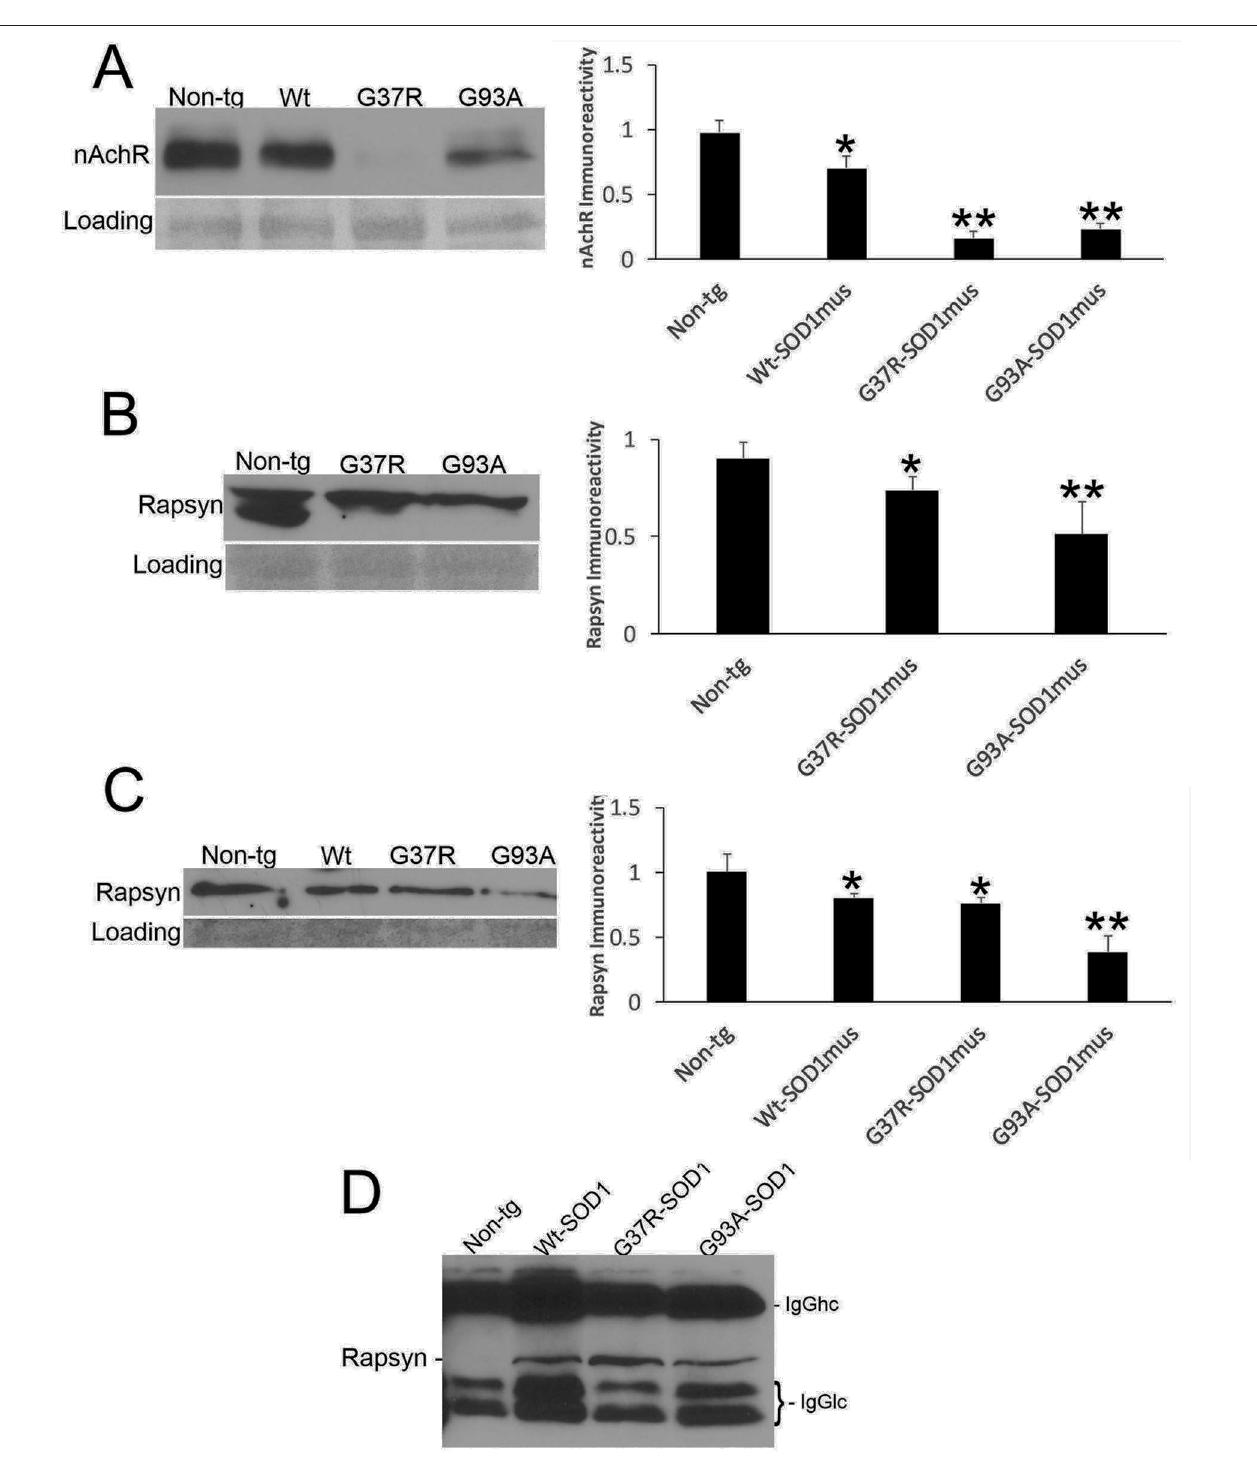
FIGURE 6 | Molecular pathology is prominent at the postsynaptic compartment of the NMJ of hSOD1 mus mice. (A) Western blotting showed depletion of nicotinic acetylcholine receptor (nAchR) in hindleg skeletal muscle of WT, G37R, and G93A mutant mice (mean ± SD, p < 0.05; ** p < 0.01). Ponceau S stained membrane shows protein loading. (B) Scaffold protein rapsyn in diaphragm of G37R and G93A mutant mice (mean ± SD, p < 0.05; ** p < 0.01). Ponceau S stained membrane shows protein loading. (C) Western blotting showed depletion of the scaffold protein rapsyn in hindleg skeletal muscle of WT, G37R, and G93A mutant mice (mean ± SD, * p < 0.05; ** p < 0.01). Ponceau S stained membrane shows protein loading. (D) Immunoprecipitation of hSOD1 in hindleg skeletal muscle extracts followed by western blotting for rapsyn showed co-precipitation of hSOD1 and rapsyn in tg mice.